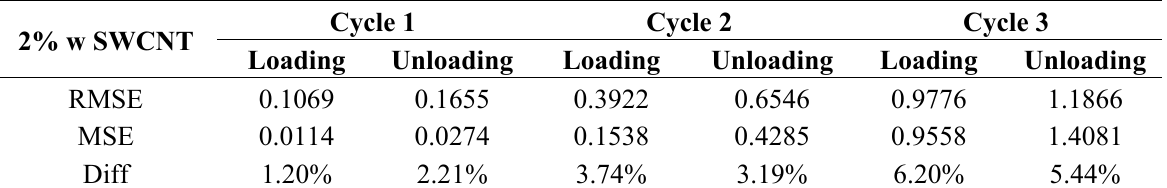
Table 7. Predicted quadratic (RMSE) and median square (MSE) error values for PC/ABS-reinforced material data shown in Figure 13. Here, “Diff” represents the maximum percentage error between theoretical and experimental